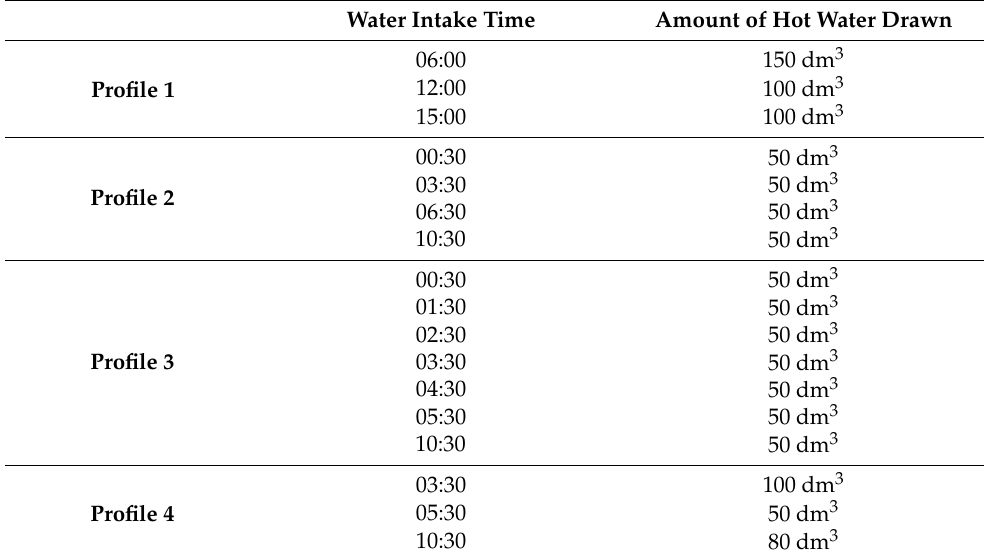
Table 1. Schedule of hot water consumption for inlets.